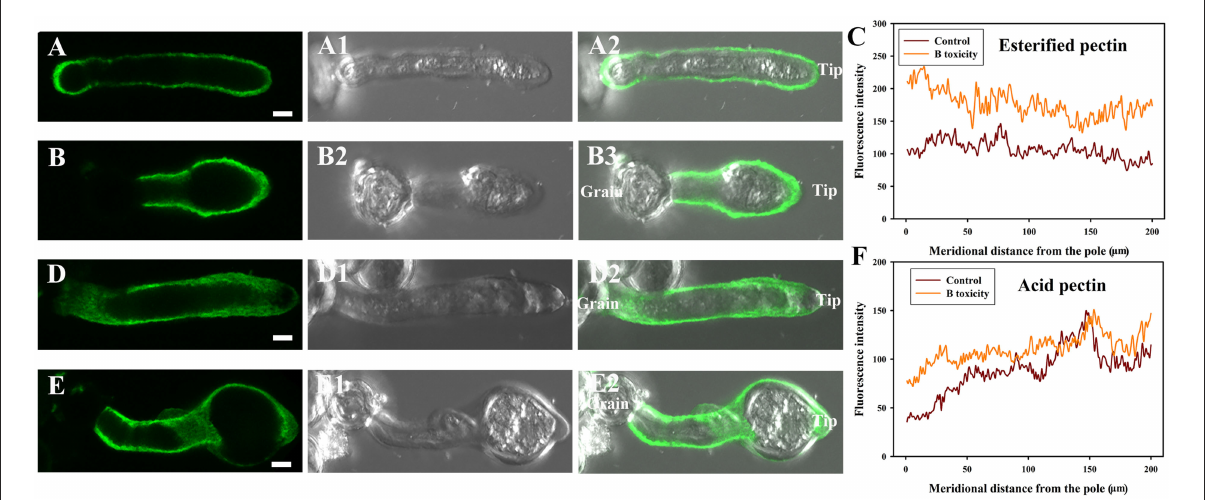
FIGURE2 Influence of B toxicity on esterified and acid pectins distribution of C . mollissima pollen tube wall. (A) Esterified pectins in the control pollen tube indicated by JIM 7 labeling. (B) Esterified pectins in B toxicity-treated pollen tube. (C) Quantitative analysis of the fluorescent intensity of esterified pectins in the wall of control (Control) and B toxicity-treated pollen tubes (0.8mM H 3 BO 3 ). (D) Acid pectins in control pollen tube indicated by JIM 5 labeling. (E) Acid pectins in B toxicity-treated pollen tube. (F) Quantitative analysis of acid pectins fluorescent intensity in the wall of control (Control) and B toxicity-treated pollen tubes. Bar = 5 µ m.